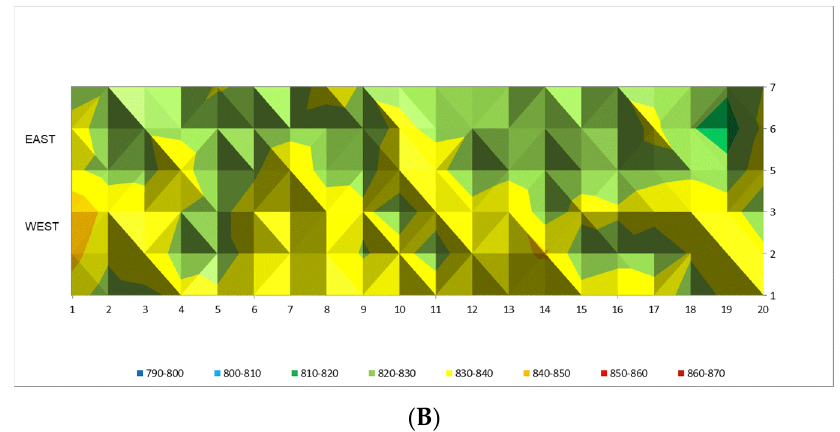
Figure 14. ( A ) Tube wall temperature readings before implementation of recommendations from the model. ( B ) Tube wall temperature readings after implementation of recommendations from the model.